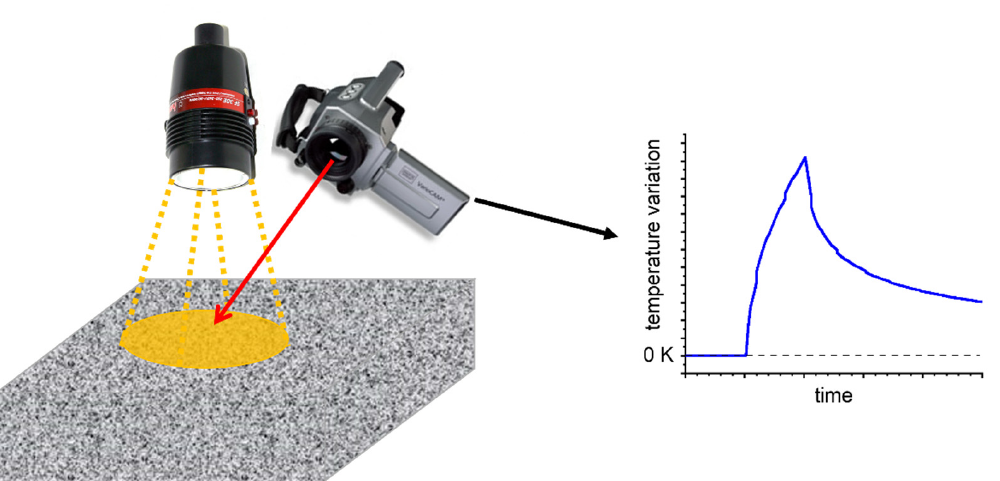
Figure 1. Schematic of the technical implementation of the photothermal method. The red arrow indicates the optical axis of the infrared camera; the diagram with the blue curve represents the measured surface temperature transient.